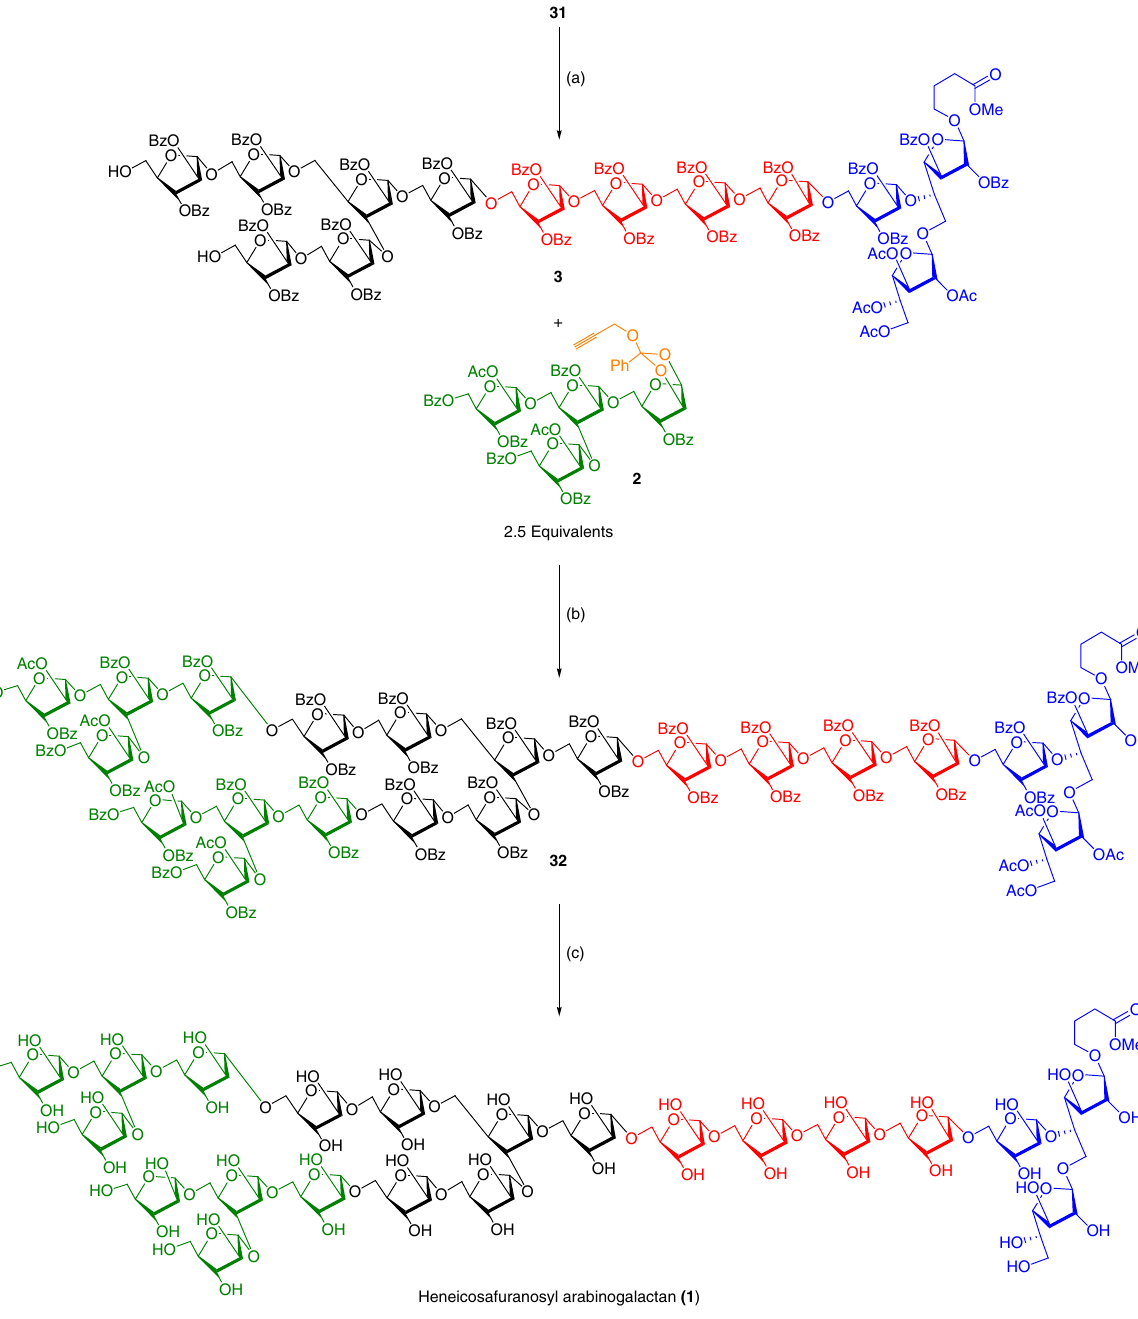
Figure 9 | Synthesis of heneicosafuranosyl arabinogalactan (1). Reagents and conditions: (a) Py (cid:2) HF, THF:Py (5:1), 0 (cid:2) C - 25 (cid:2) C, 4h, 85%. (b) AuCl 3 (7mol%), AgOTf (7mol%), CH 2 Cl 2 , 4Å MS powder, 25 (cid:2) C, 24h, 71%. (c) 0.5M NaOMe, MeOH, CH 2 Cl 2 , 4h, 25 (cid:2) C, Glycosidation by n -pentenyl glycosides . To a CH 2 Cl 2 solution (5ml) containing glycosyl donor (0.1–1mmol) and aglycon (0.1–1mmol)) with 4Å molecular sieves powder (0.1–1.0g) was added 3molar eq. of N -iodosuccinimide (NIS) at 0 (cid:2) C in ice bath and stirred for 10min 21 . After 10min, catalytic amount of TfOH (0.3eq.) was added to the reaction mixture at 0 (cid:2) C and stirred at 25 (cid:2) C. After complete disappearance of the donor (adjudged by TLC), the reaction mixture was neutralized by the addition of Et 3 N and filtered through a pad of celite. The filtrate was washed with sat. aqueous solutions of sodium bicarbonate and sodium thiosulphate. Combined organic layers were dried over sodium sulphate and concentrated in vacuo . The resulting residue was purified by flash silica gel column chromatography using ethyl acetate-petroleum ether to obtain 1,2- trans glycosides. Pent-4-enyl glycosides to propargyl orthoesters . Pent-4-enyl furanoside (1–50mmol) was dissolved in anhydrous CH 2 Cl 2 (10–500ml) and cooled